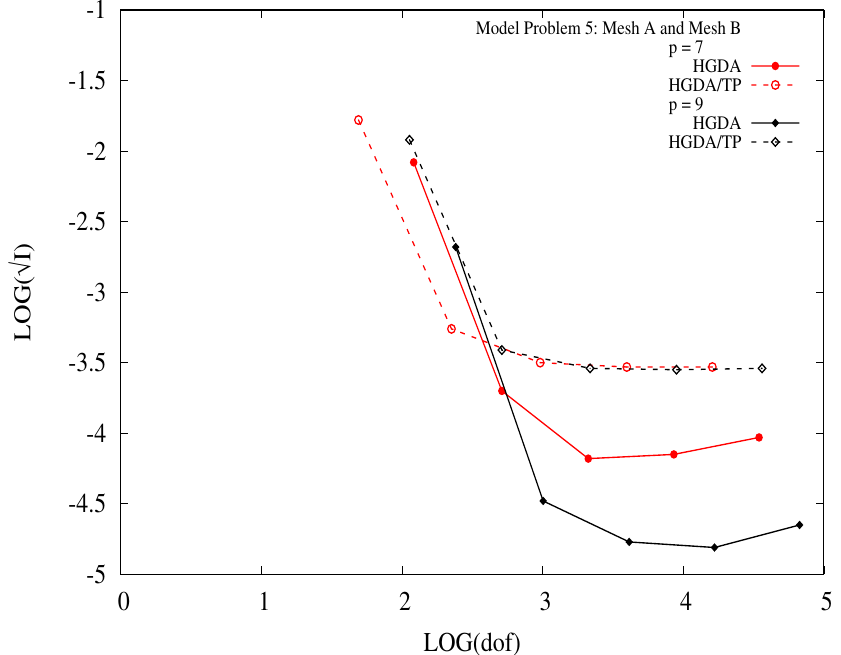
Figure 27. Residual function I versus dof, C 33 solutions: Model Problem 5 (Convection Diffusion Equation; Mesh B, HGDA/DG; Mesh A,